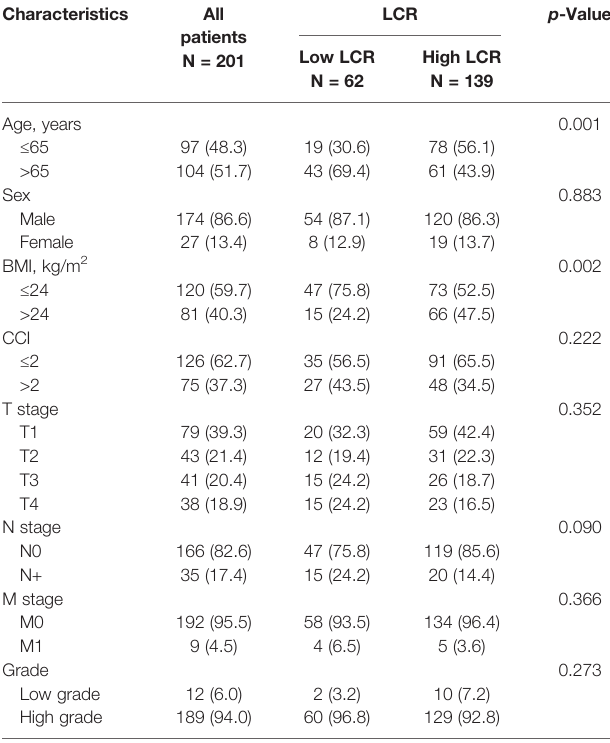
TABLE 1 | Clinical characteristics of the patients according to LCR before